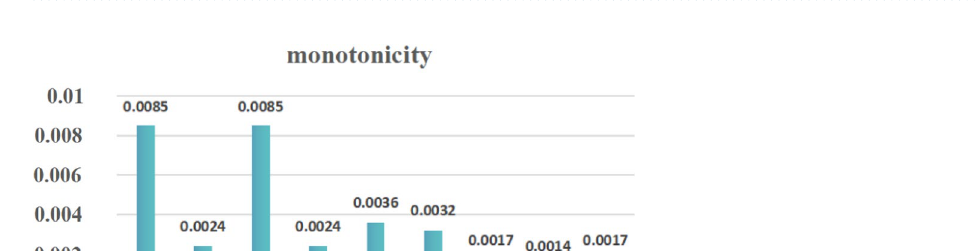
Figure 8. Time-domain features of dataset2 bearing 1 ( a ) mean; ( b ) peak; ( c ) RMS; ( d ) RRMS; ( e ) max; ( f ) var; ( g ) std; ( h ) kurtosis; ( i ) skeweness.